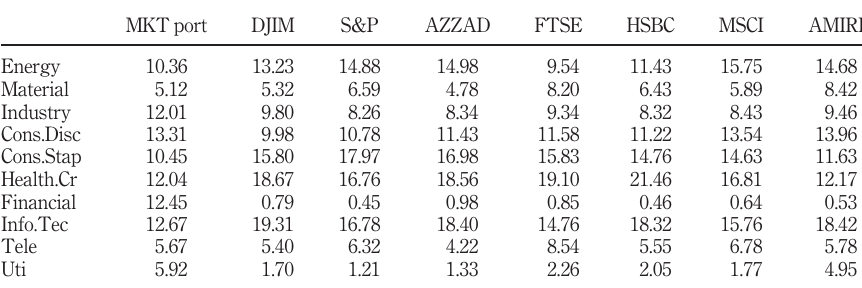
Table 2. Sector allocation of the